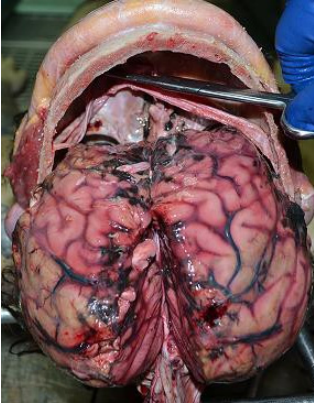
Figure 2. Brain examination. In the temporal and parietal lobes, some nodular blackish rounded soft formations with blood were observed. Healthcare 2021 , 9 , 341